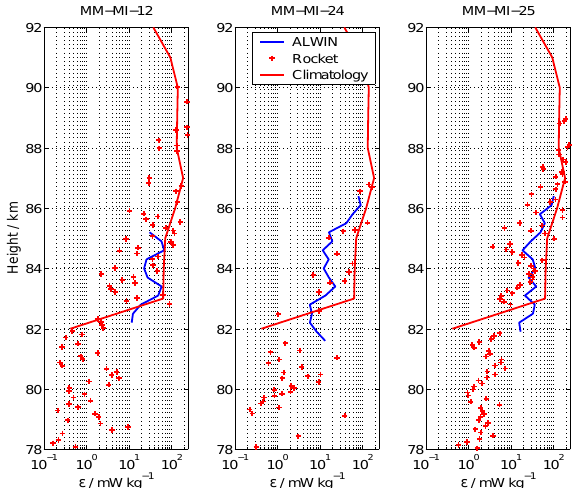
Fig. 11. Height distribution of signal power between 01/07/2002 and 07/07/2002 during the MIDAS/MaCWAVE campaign. The fig- ure shows the number of received echo power of the vertical beam which are larger than 30 and 50dB. The occurrence rate ( n Signal ) is normalized to the total number of observations ( N